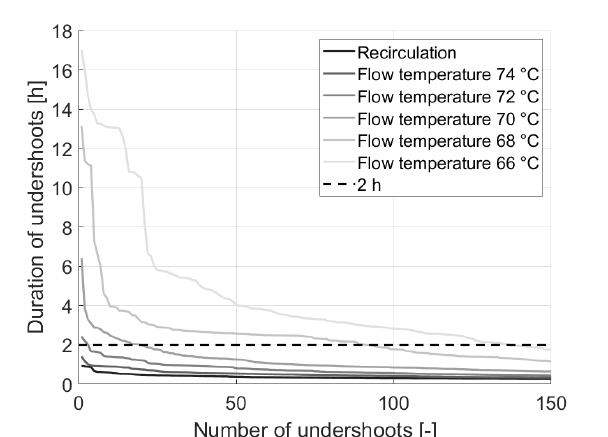
Figure 23. Zone temperature undershoot time of different applied WCC design set